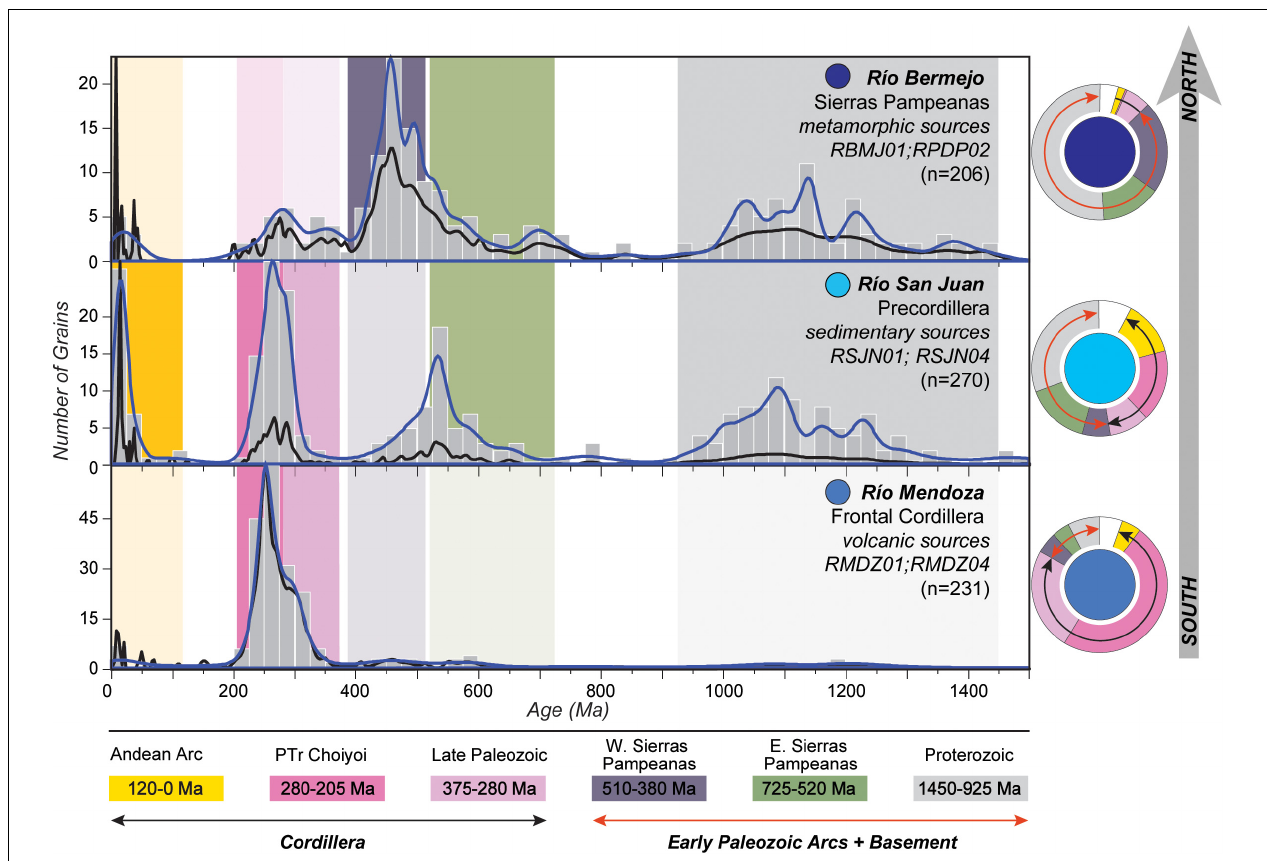
FIGURE 3 | Comparative plot of detrital zircon (DZ) U-Pb age distributions for modern river sands, depicted as age histograms (gray rectangles), kernel density estimates (blue line), and relative probability density plots (black line), with emphasis on key age populations (dark color shading) and minor to no age populations (transparent color shading). Donut diagrams represent percent abundance of key age populations in each sample, with Cordillera (black arrows) and Early Paleozoic Arcs and Basement (red arrow) age groups emphasized, and inner colored circle corresponds to sample locations in Figure 2B .